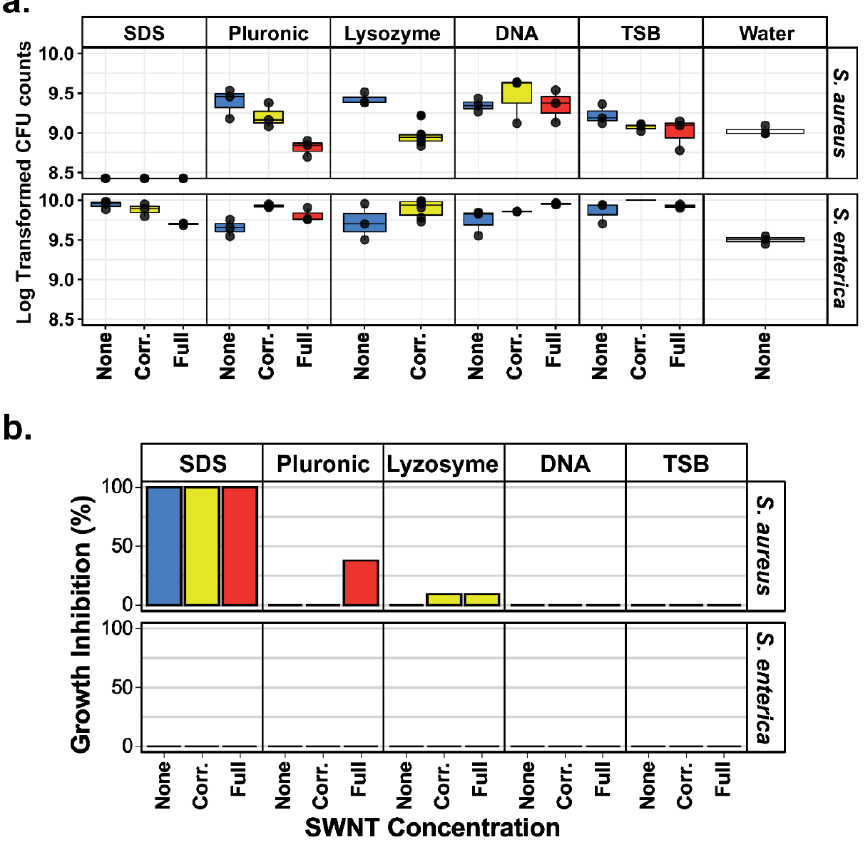
Figure 3. Cell viability measured by CFU counts. ( a ). CFU counts in triplicate of the challenges for Staph. aureus and Salmonella . Log 10 transform was used to coerce the data into a more normal distribution and facilitate visualization. ( b ). Antimicrobial activity of the dispersants with different SWNT concentrations. Antimicrobial activity measured as cell viability loss in relation to a water challenge. None: No SWNTs; Corr.: SWNT concentration corrected to 0.23 mg/mL for comparison across all dispersants; Full: Full-strength SWNT concentrations as shown in Table 2.